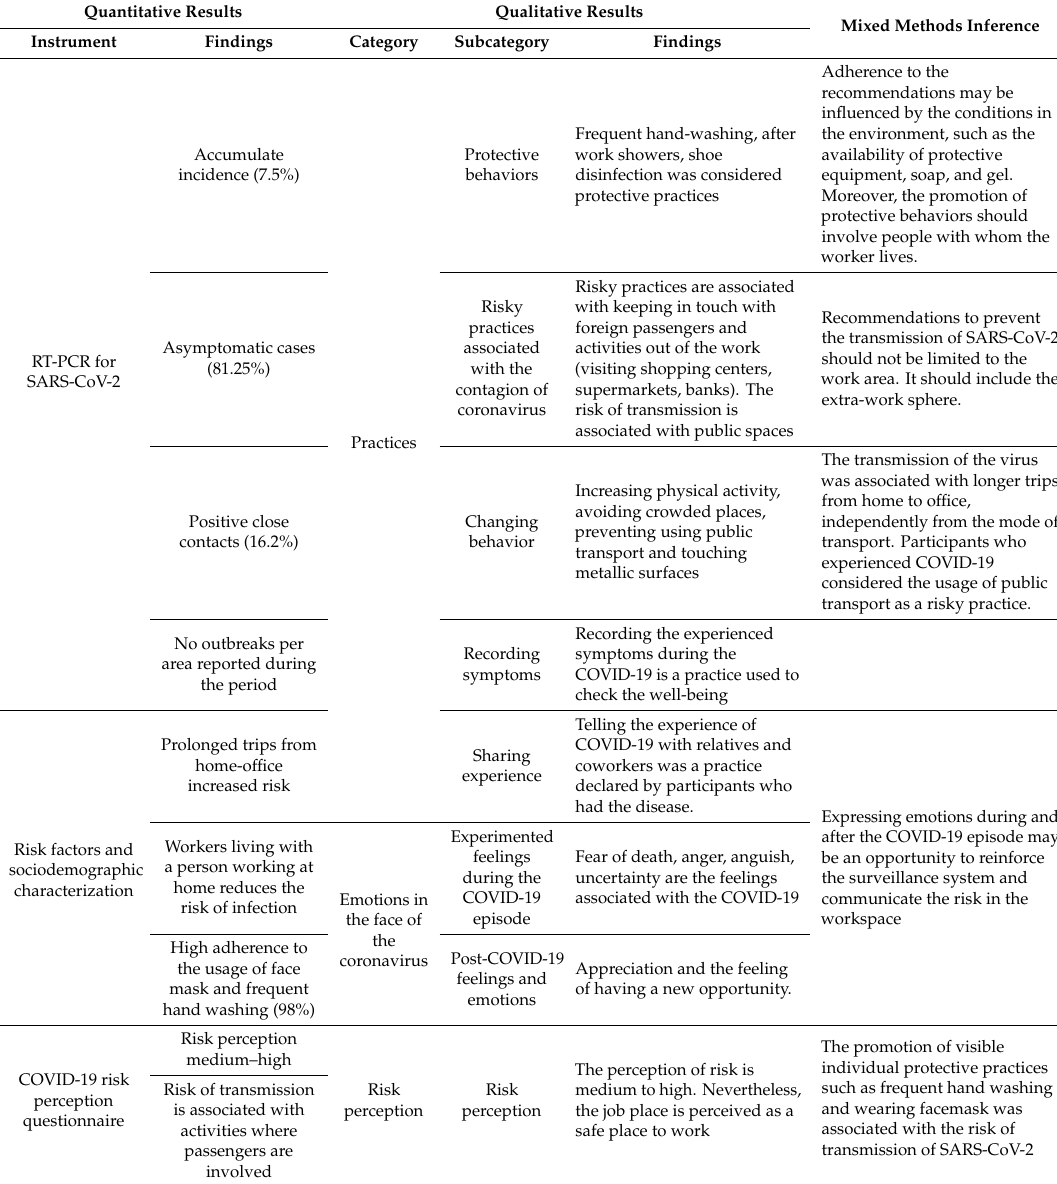
Table 6. Joint result of SARS-CoV-2 risk perception among the airport